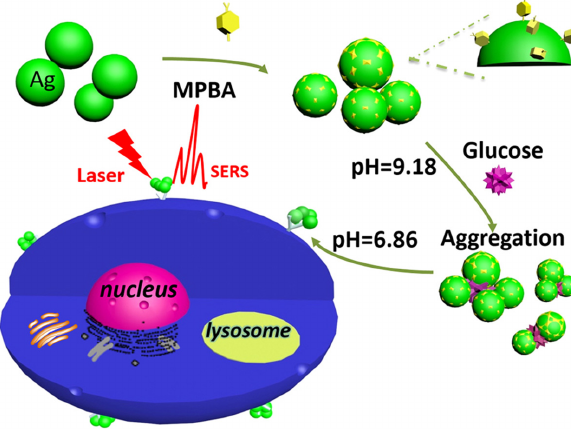
Figure 10: Targeted identification of the cancer cell by a highly sensitive Glucose-MPBA@AgNPs nanoprobes. Reprinted